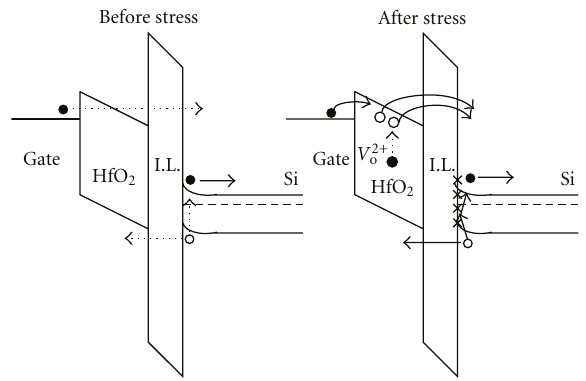
Figure 9: Band diagram of I G - V G curve in depletion and weak inversion region.